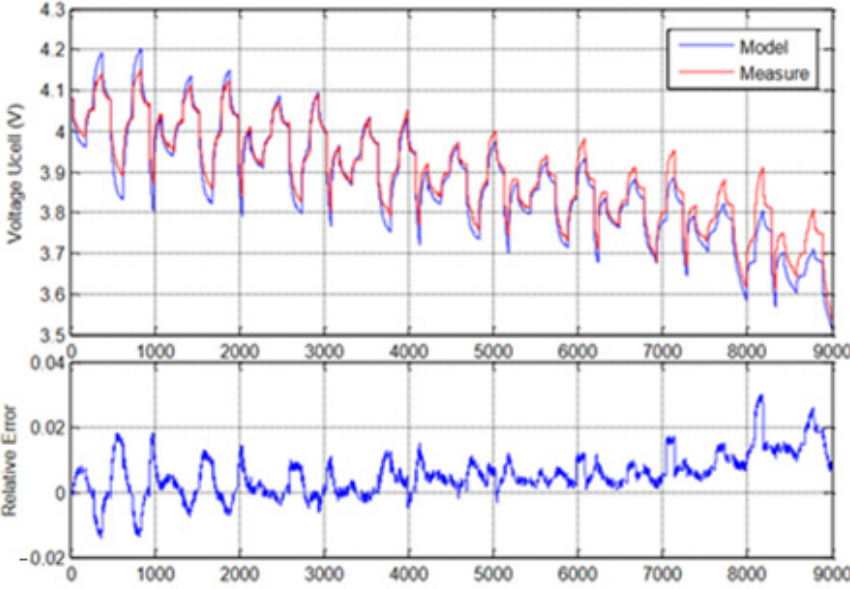
Figure 8. Cell voltages of the measurement and the identified Thevenin model and relative error.